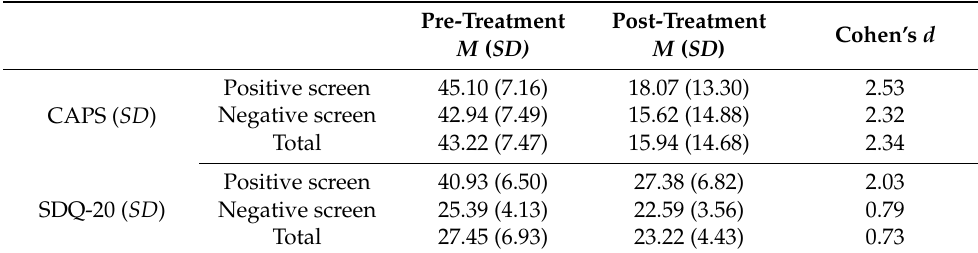
Table 2. Mean scores and SDs on the main outcome